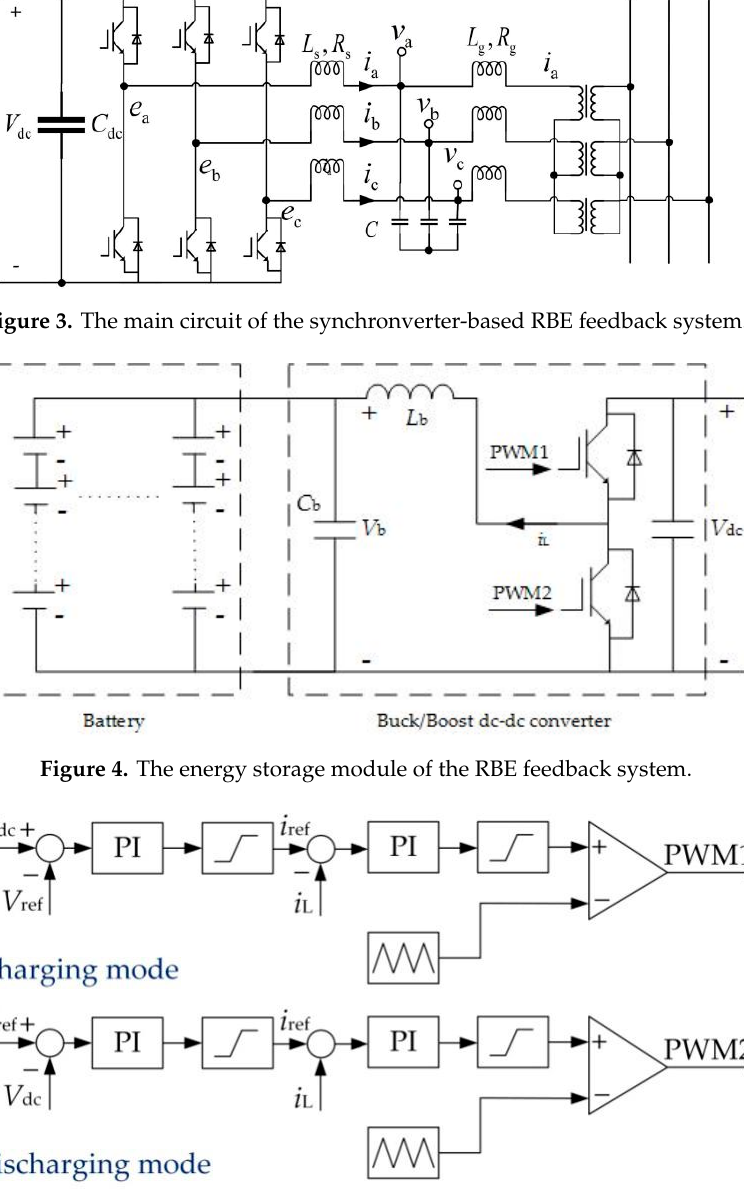
Figure 5. The double closed-loop controller.